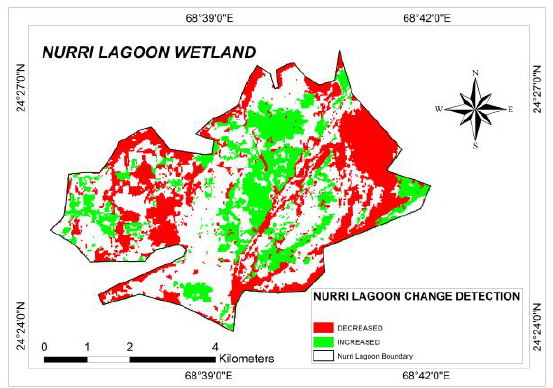
Figure 10: Landcover classification map of Nurri Lagoon 2016 Water has almost vanished from the main lagoon area found in 2006 while vegetation has increased during this period. Nurri lagoon is brackish in nature and because of ocean water intrusion its salinity is increasing.